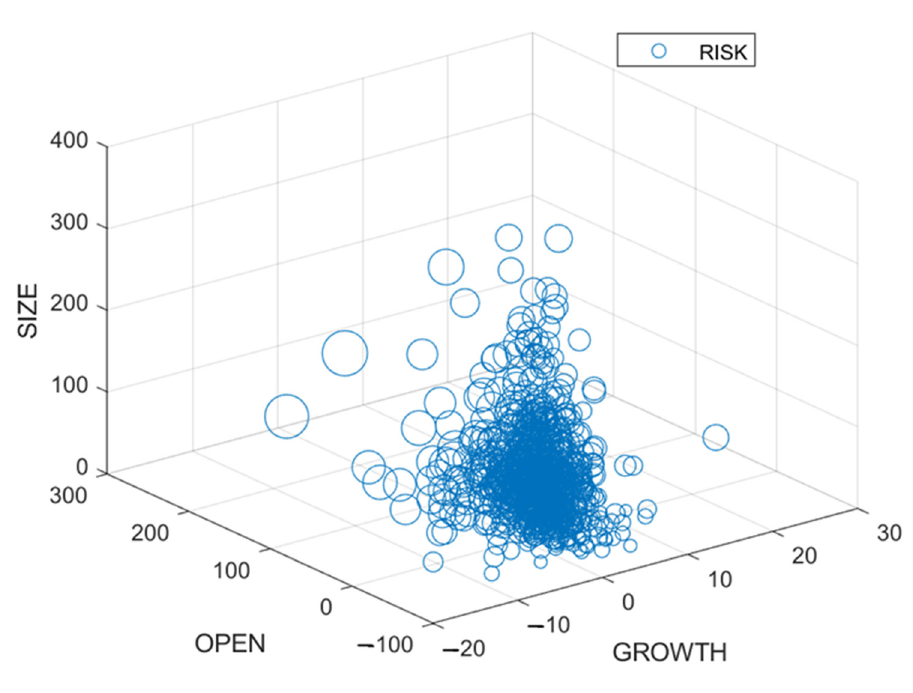
Figure 4. Economic growth, openness, size and risk diversification of the stock market